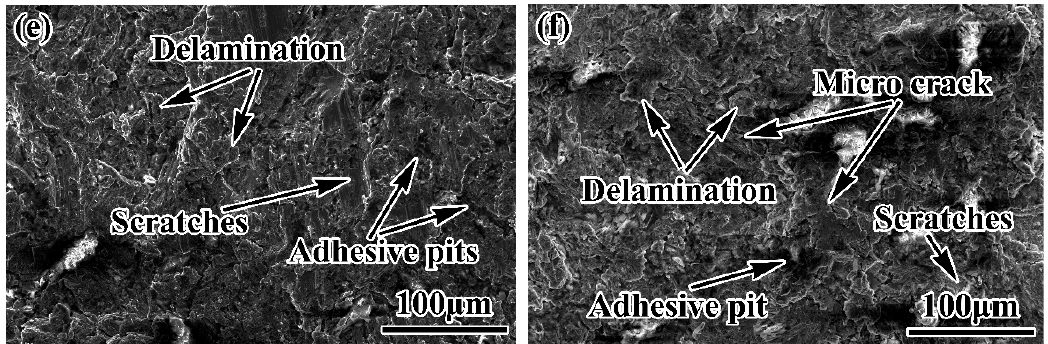
Figure 7. Wear surfaces of the test steels tempered at different temperatures: ( a ) as-quenched; ( b ) 200 °C; ( c ) 240 °C; ( d ) 260 °C; ( e ) 300 °C; ( f ) 400 °C.